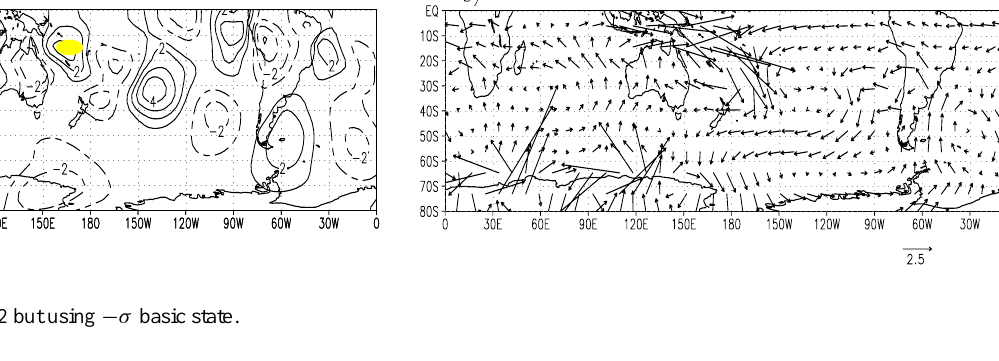
Fig. 3. The same as Fig. 2 but using − σ basic state.